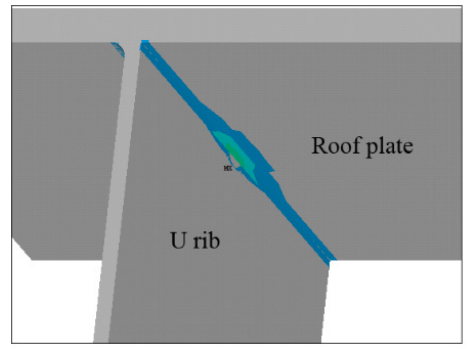
Figure 19. Mises stress distribution of the rib-to-deck connection.